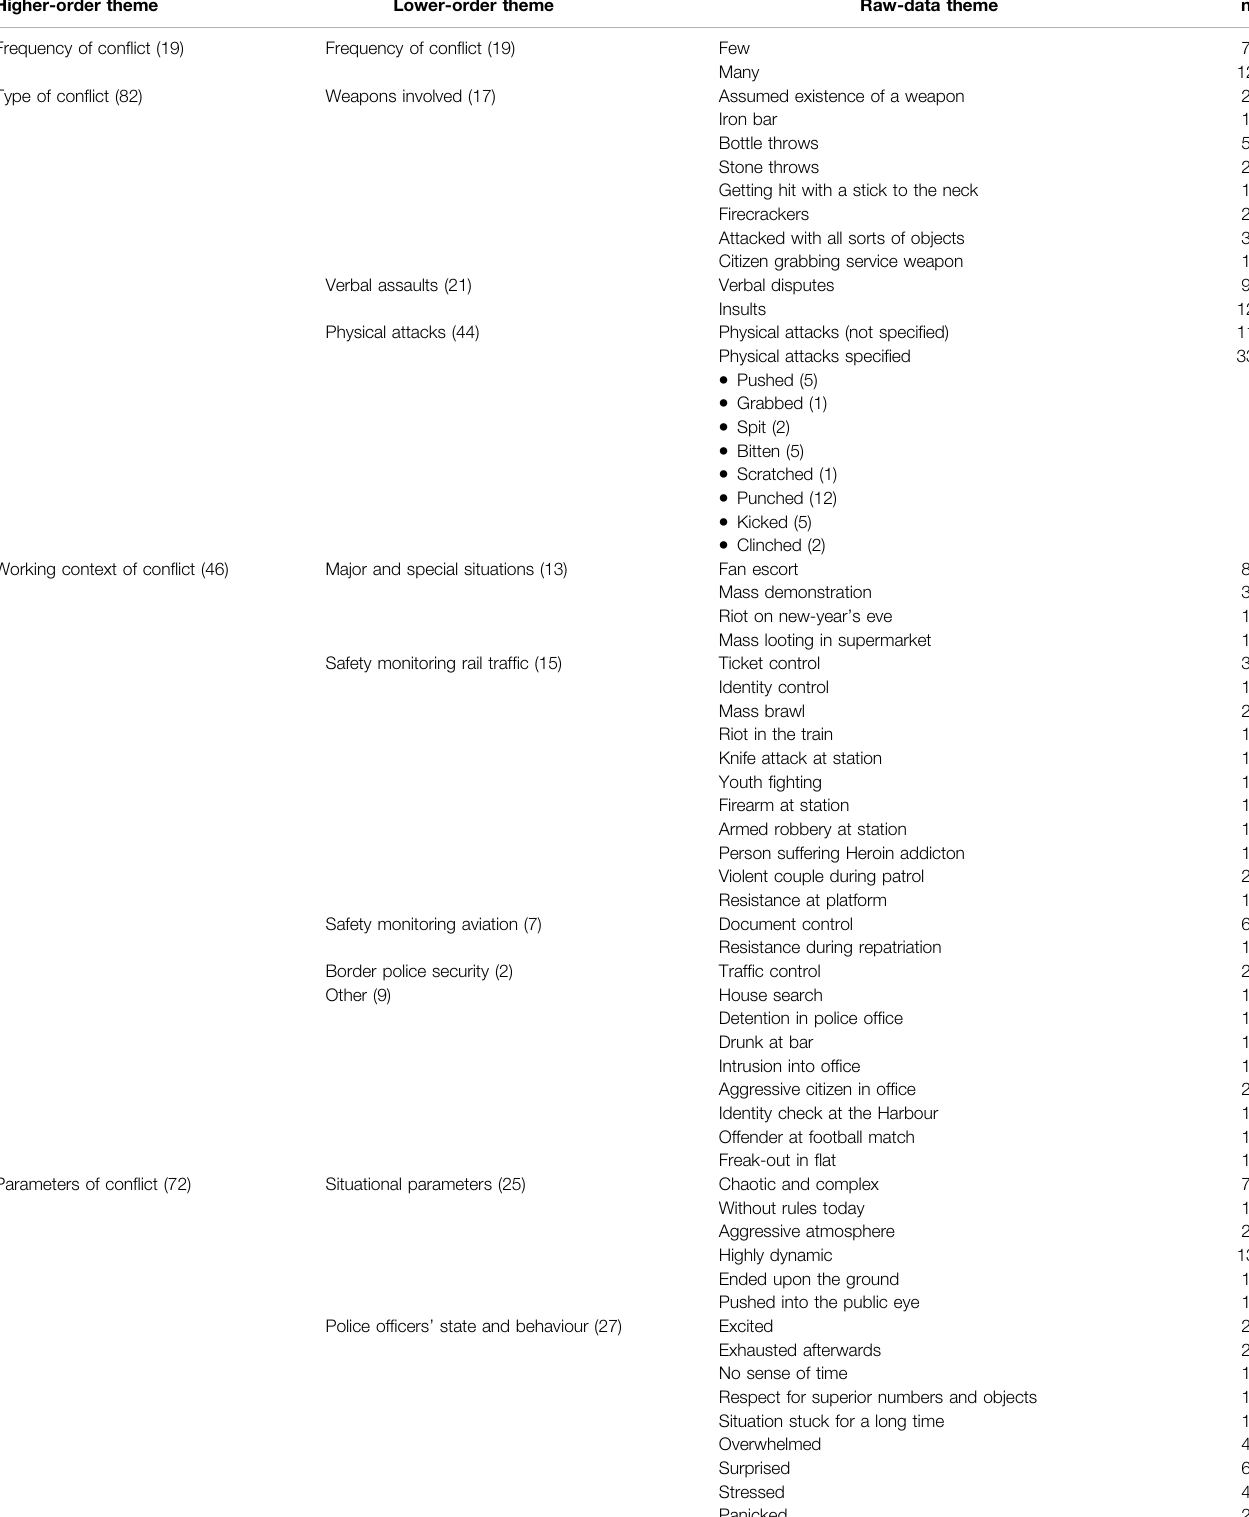
TABLE 2| Results ofqualitative analysisofcon fl ictsexperiencedbyGermanfederal policeof fi cers(Numbersincolumn “ n ” denotethenumberofparticipants contributing to the raw-data theme; within the columns of lower-order and higher-order themes, numbers in brackets denote the total number of meaning